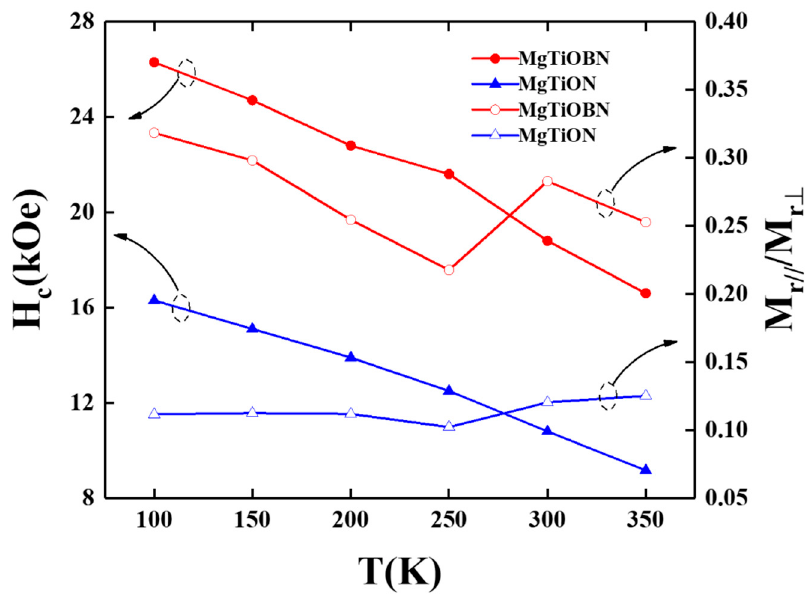
Figure 5. Temperature dependence of coercivity (normal to film surface) and remanence ratio of reference sample and FePtCAg/MgTiOBN films.